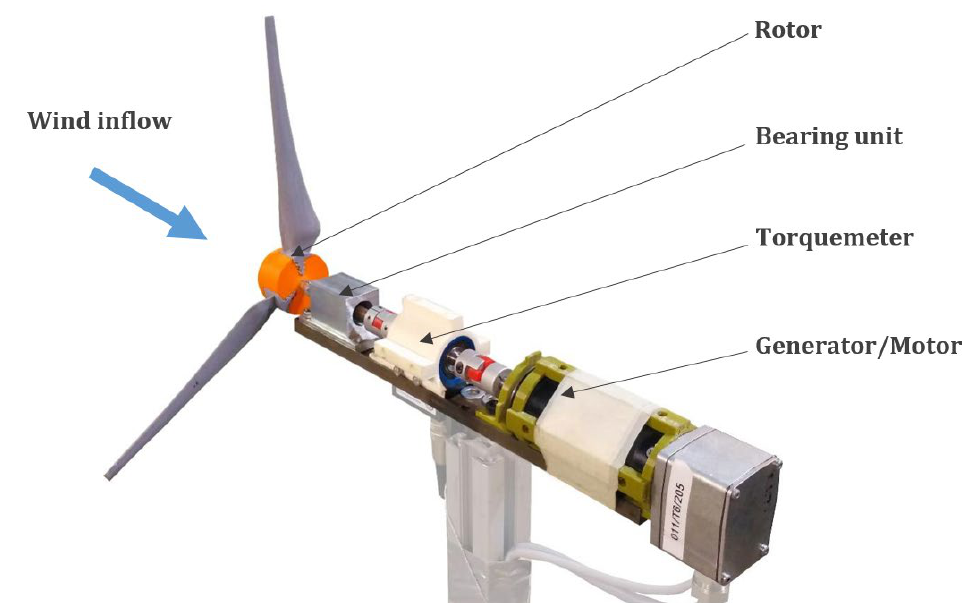
Figure 8. Illustration of the test stand (without a casing) with the FX rotor mounted.